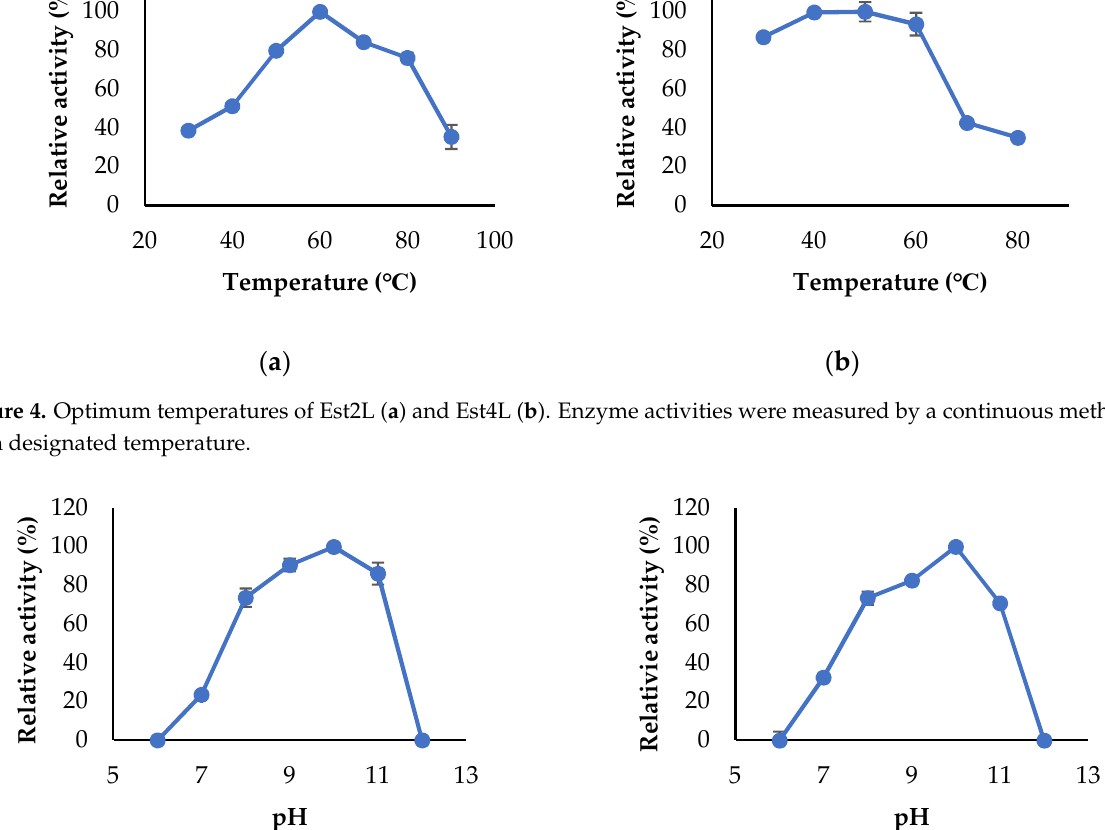
( b ) Figure 6. Thermal stabilities of Est2L ( a ) and Est4L ( b ). Enzyme activities were measured by a continuous method after preincubation of enzyme at each designated time. Regarding substrate specificities for p-NP esters, Est2L showed the highest activity with C2, followed by C4 (73.5%) and C6 (46.2%) (Figure 7a). It did not show any significant activity with p-NP ester substrates with more than 8 carbon chains, and showed the typical substrate specificity of acetylesterase. However, Est4L showed the highest reactivity with C10, followed by C2 (95.2%) and C4 (94.6%) to a similar extent (Figure 7b). Moreover, Est4L showed more than 50% of relative activities for C8 (73.6%), C12 (55.6%), and C6 (50.6%). The activities for C14 and C16 significantly decreased to 13.3% and 2.8%,